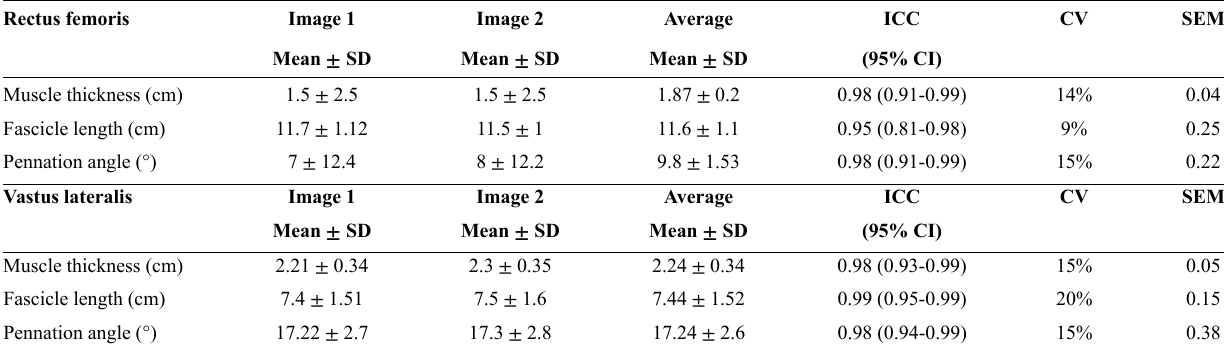
Table 1 - Descriptive and reliability statistics for muscle architecture data (n = 10).